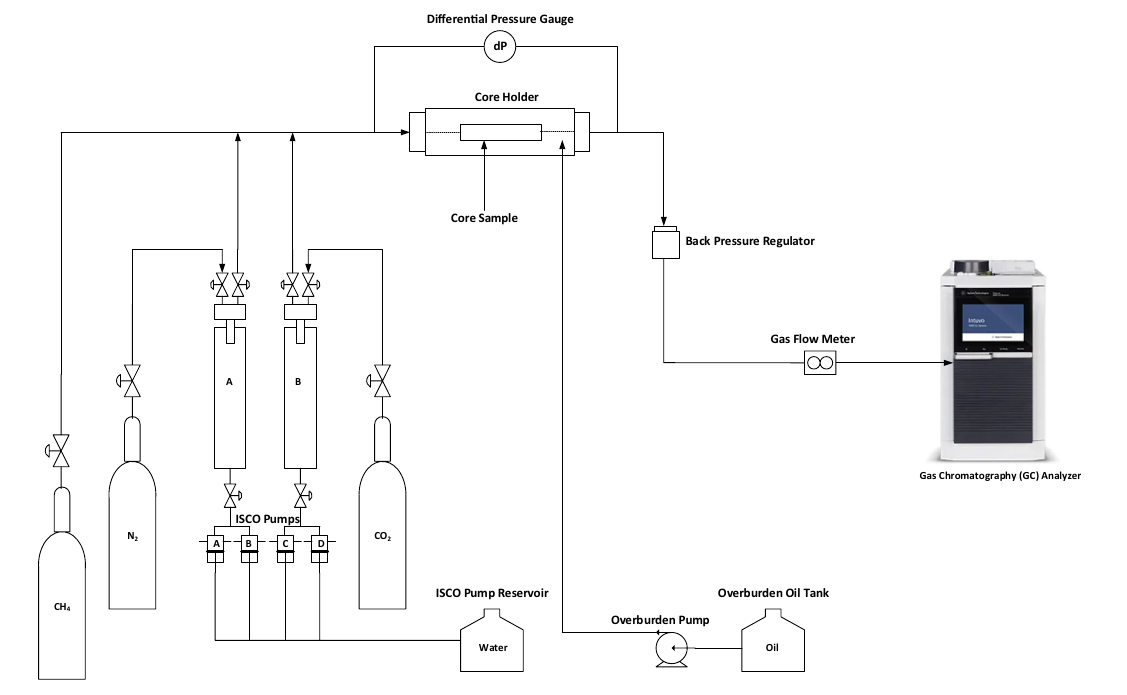
Fig. 1 Schematics of experimentational set-up for gas alternating gas